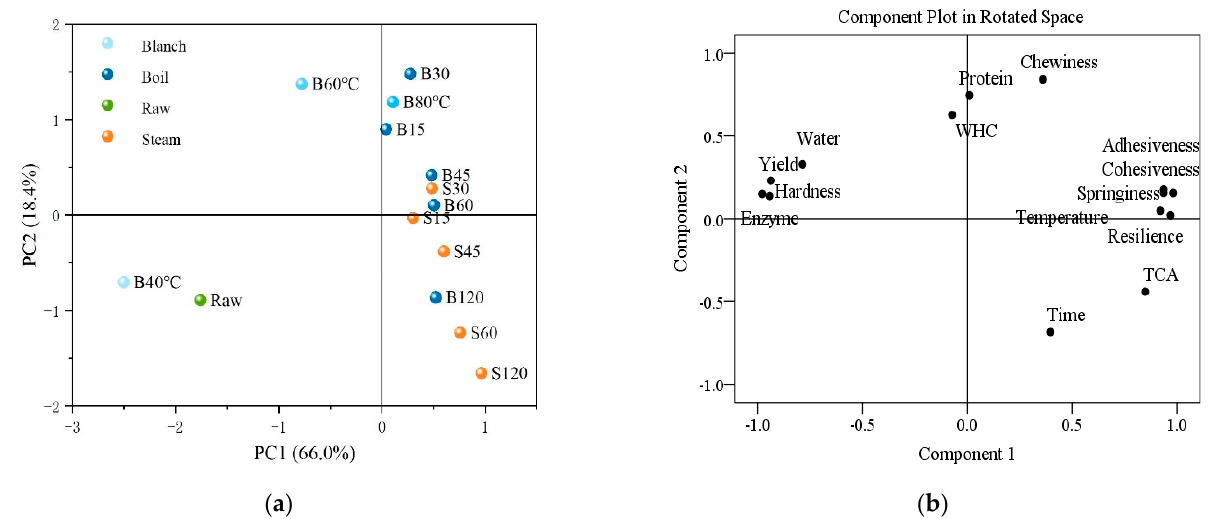
Figure 7. Principal component PC1 and PC2 scores plot ( a ) and component plot in rotated space from the principal component analysis of C. frondosa samples ( b ) assessing the effects of blanching, boiling, and steaming at different temperatures and cooking durations. Raw is sample without heating treatment.